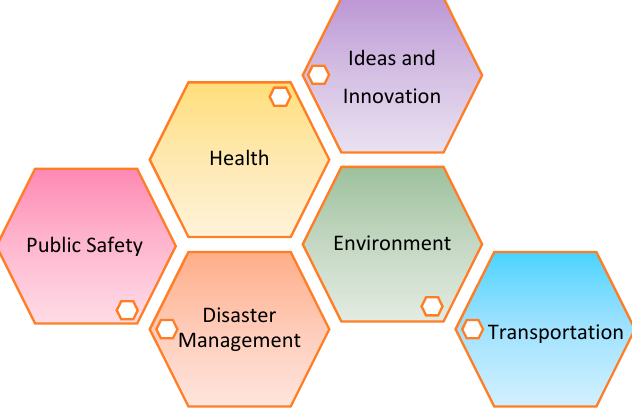
Figure 2. Areas of application of crowdsourcing in the context of smart city planning.